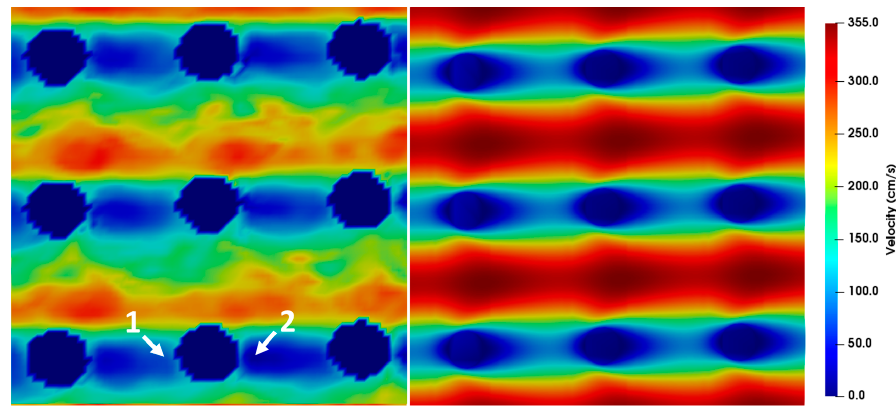
Figure 13. µPIV measurements ( left ) compared to simulations ( right ) showing the velocity field around posts at Re = 30.48. The direction of flow is from left to right and the pitch between the posts is 20 µm and the time difference between double frames is Δ t = 0.6 µs. For a better highlighting of the asymmetry, two arrows are inserted into the picture. The velocity before the post is higher (arrow 1) than the velocity after the post (arrow 2). Furthermore, the µPIV measurements do not attain the maximum velocities achieved by the simulations.